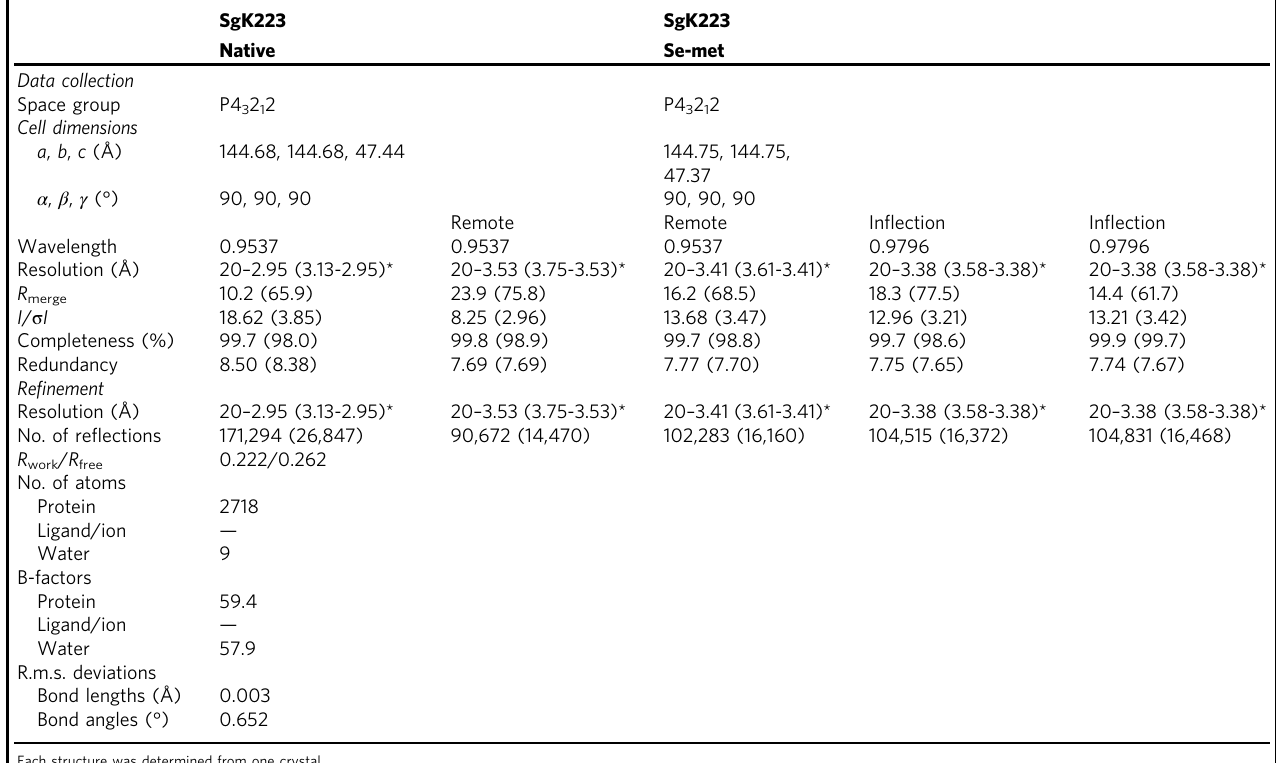
Table 1 Data collection, phasing and re fi nement statistics for MAD (SeMet)